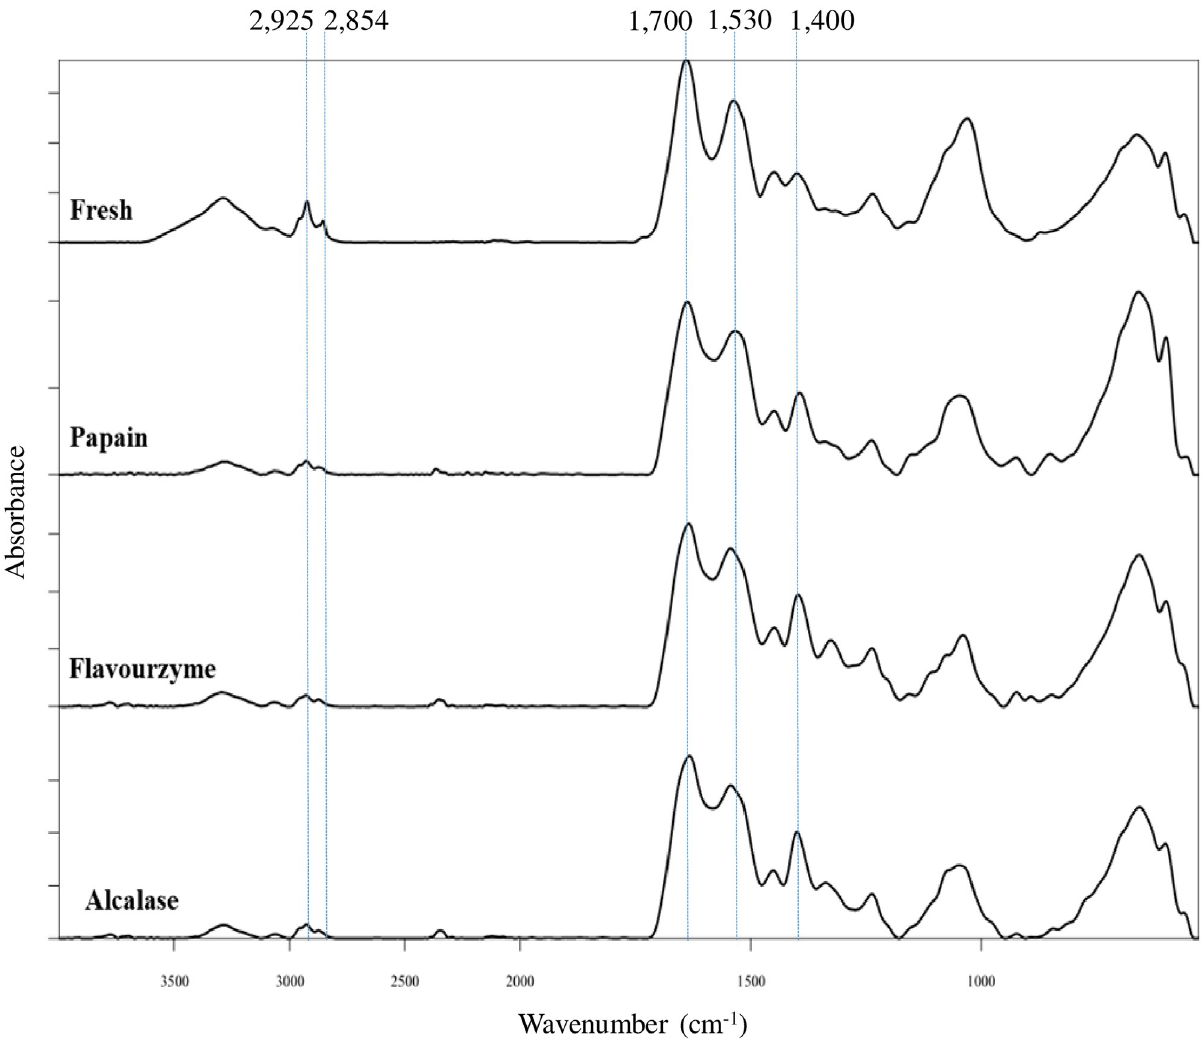
Fig 6. Fourier transform infrared (FTIR) spectra of freeze-dried porcine placenta (fresh) and freeze-dried porcine placenta hydrolysate (PPH) produced by Alcalase, Flavourzyme, and papain at 10% enzyme load for 20